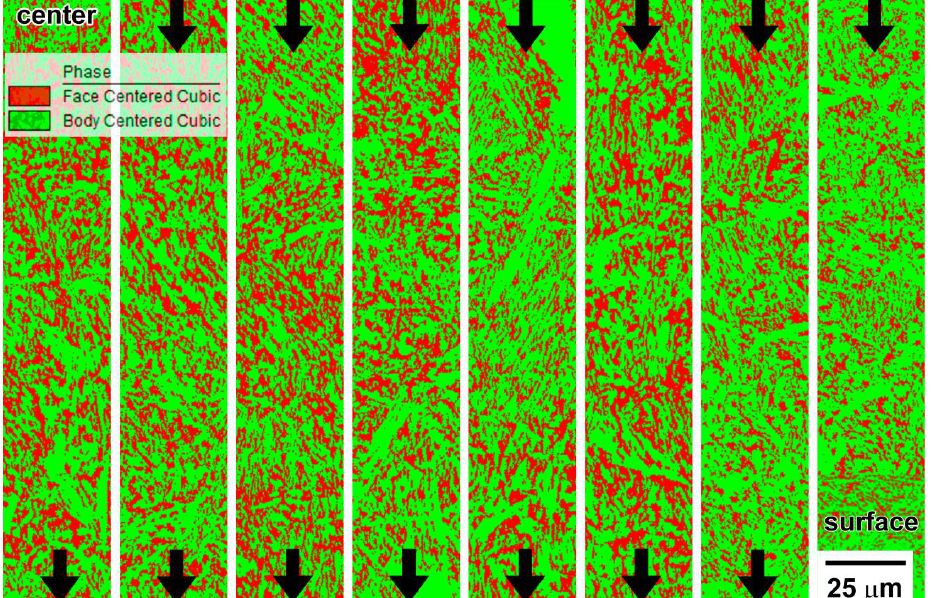
Figure 9. Phase distribution according to EBSD analysis from the center to the surface of the Fe-0.44C steel after quenching at 160 ◦